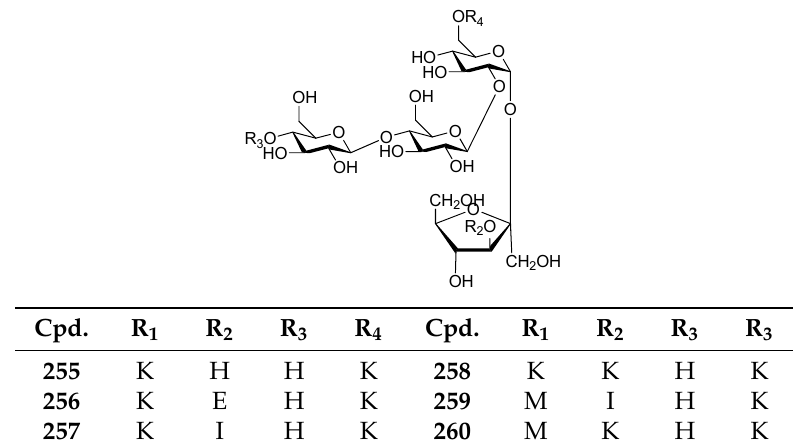
Figure 55. Structures of compounds 255 – 260 .